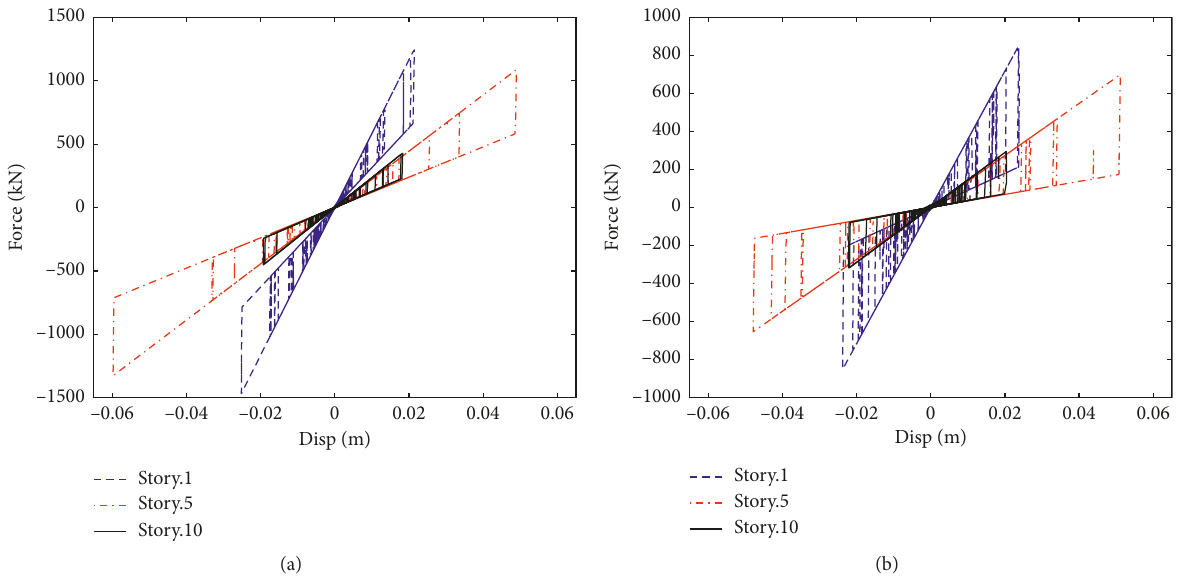
Figure 23: Hysteretic curve of Reid dampers in the structure under the action of the 0.51g El Centro wave: (a) η